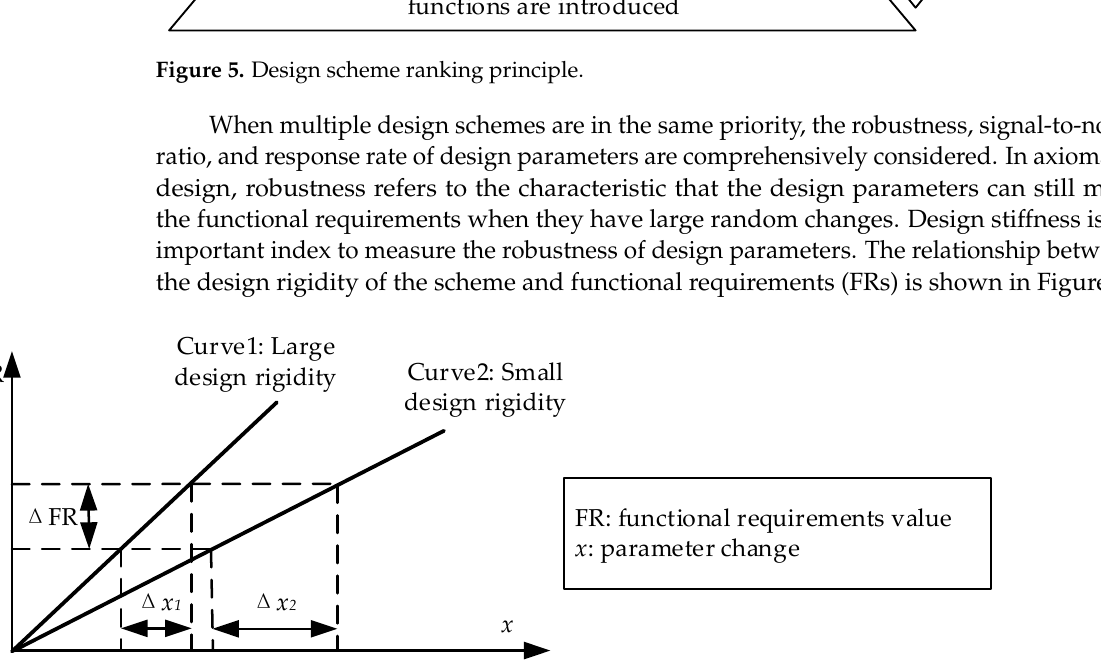
Figure 6. The relationship between the design rigidity of the scheme and functional requirements.